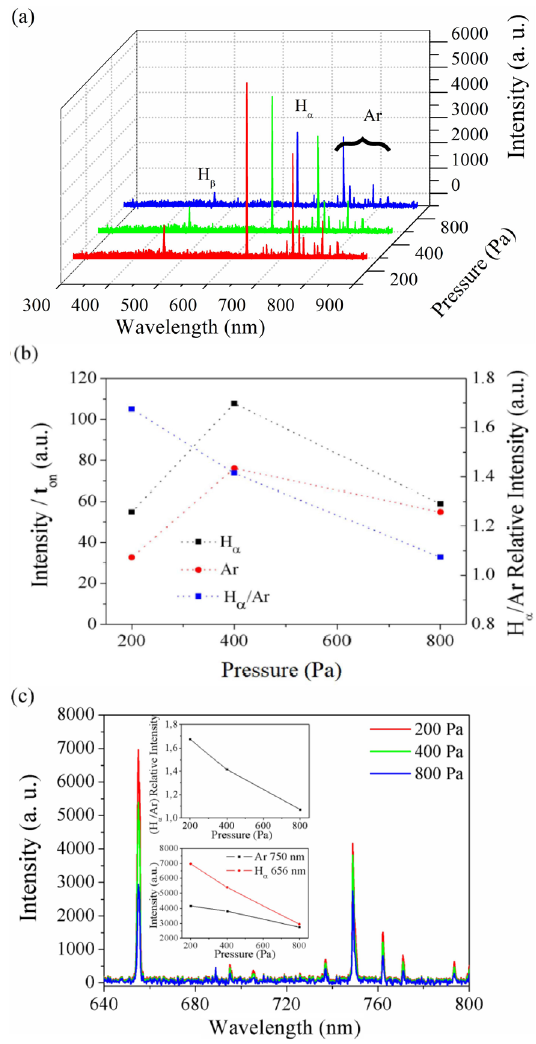
-normalized intensity OES spectra of the glow Figure 7. (a) t on discharge; (b) instantaneous H and Ar e.s. emission intensity α (represented by the Intensity / t axis spectrum evolution) and on H /Ar e.s. intensity ratio; and (c) global intensity OES spectra (not α divided by t ), for treatments carried out at 200, 400 and 800 Pa. on Treatments carried out at 450 °C, for 8 h, using 99.5% (80% H